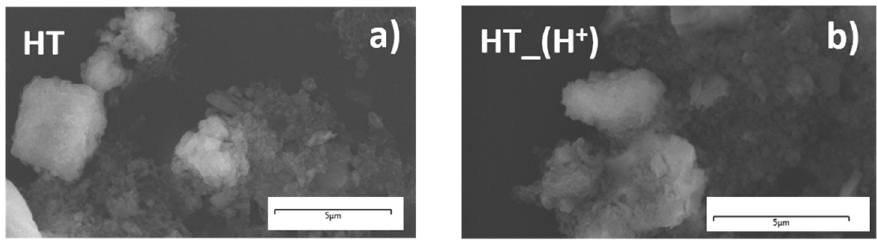
Figure 4. SEM images of raw HT sample ( a ) and after adding HCl ( b ) deposited on a polymeric substrate.